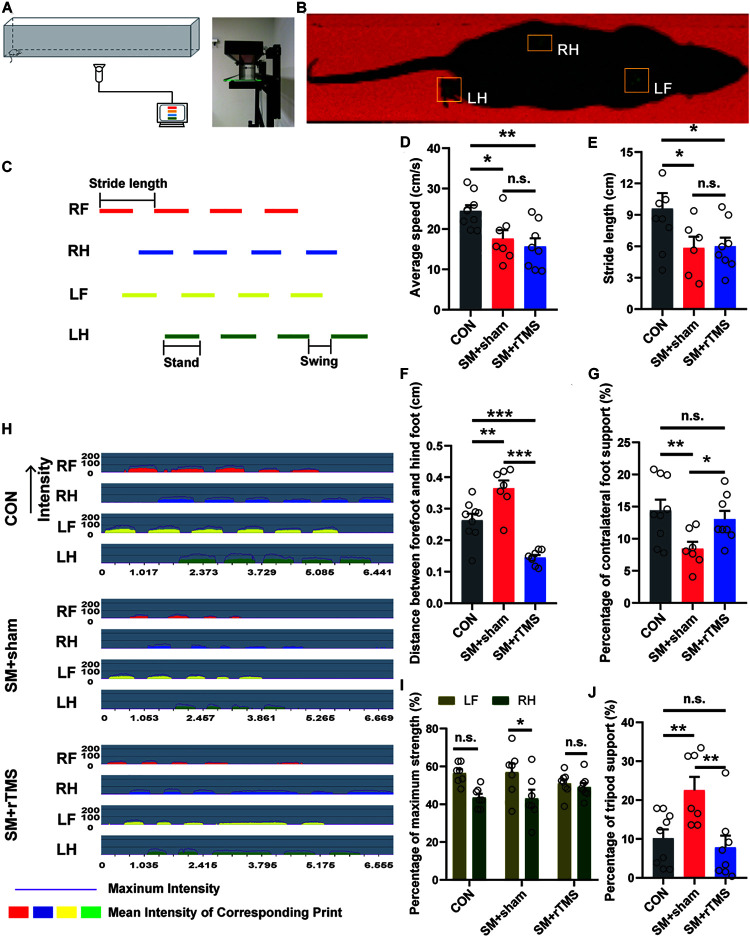
Effect of rTMS on the gait of SM rats. (A) Diagram of experimental equipment for gait test. (B) The actual trajectory of the rat walking. RF, right front; RH, right hind; LF, left front; LH, left hind. (C) The graph of the time step sequence, which reflects the sequence of different feet walking on the track. Stride length, stand, and swing definitions are shown in the figure. (D) The average speed of the rats walking on the track. (E) The length of rats’ strides during walking. (F) Distance between forefoot and hindfoot of rats. (G,J) The percentage of time spent on contralateral foot or tripod support of rats. (H) The diagram of pressure-time of the each foot of rat, which reflects the pressure of each foot contacting with the ground. The intensity ranges from 0 to 255 MPa. (I) The maximum strength of contact between the contralateral feet and the ground (LF, left front foot; RH, right hind foot). *p < 0.05; **p < 0.01, ***p < 0.001; n.s., no significant, one-way ANOVA. Error bars, SEM. See also Supplementary Figure 1.